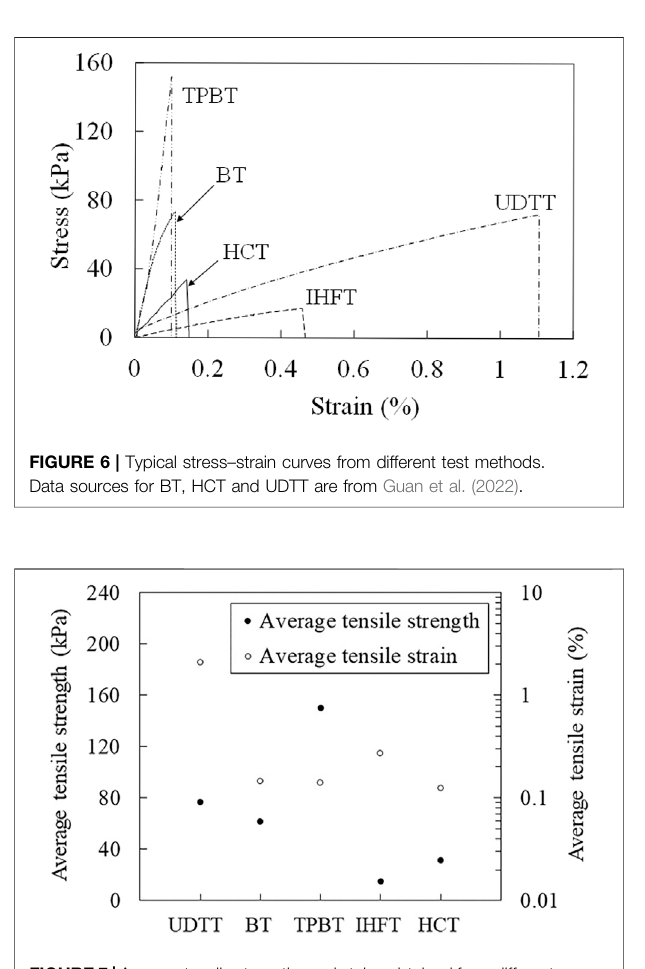
FIGURE9| Tensilestrains( ε t )atfailureandcoef fi cientsofvariation( C V )in different test